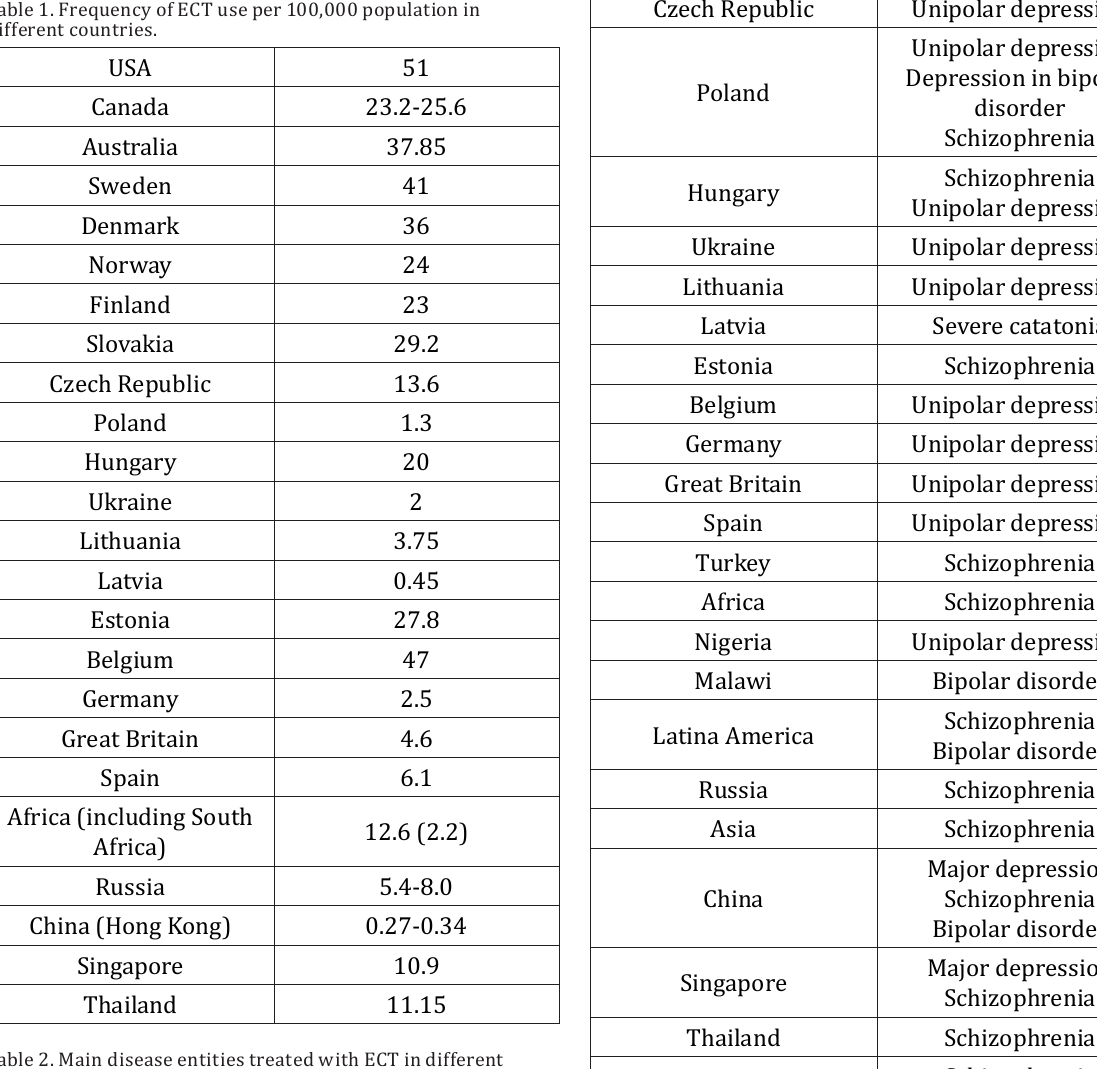
Table 2. Main disease entities treated with ECT in different